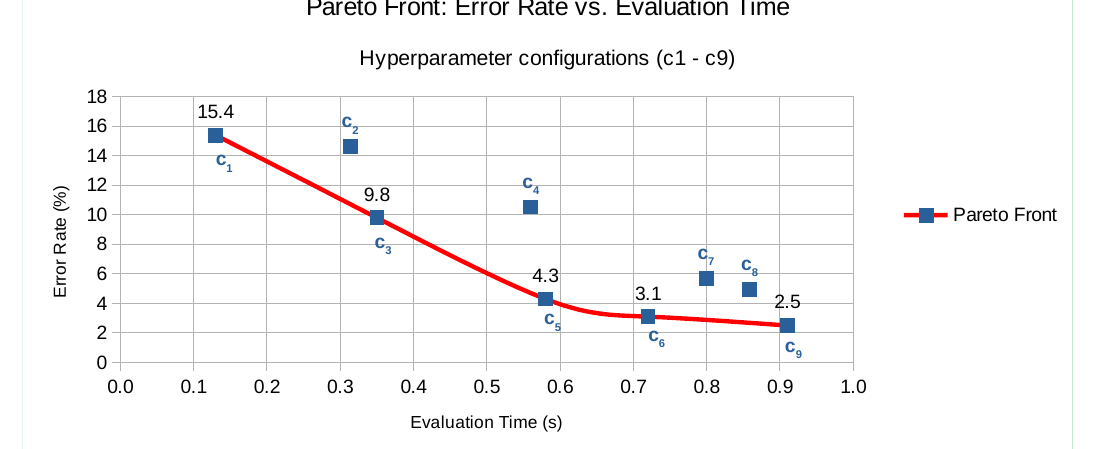
Figure 4. Pareto front of nine hyperparameter configurations ( c 1 to c 9 ) demonstrating the error rate versus evaluation time